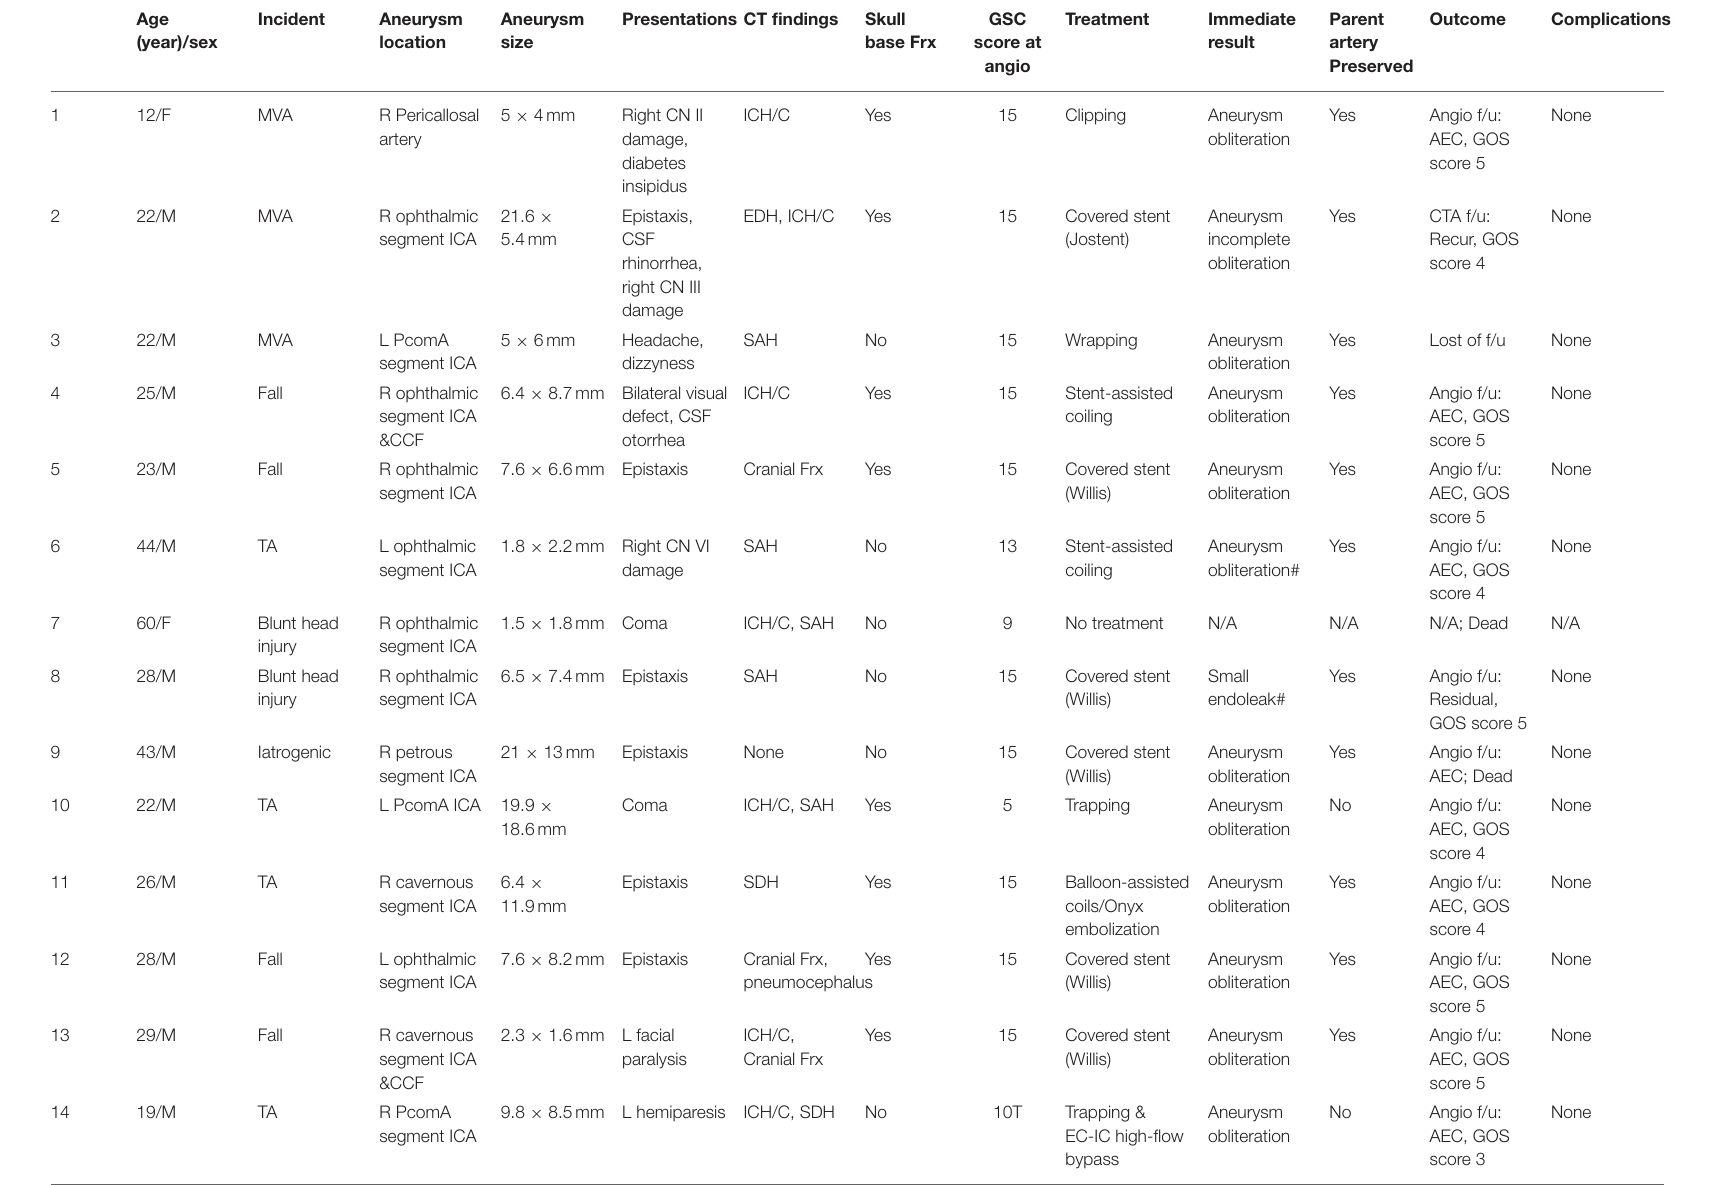
TABLE 1 | Detailed clinical characteristics of the patients presenting with traumatic intracranial aneurysms.